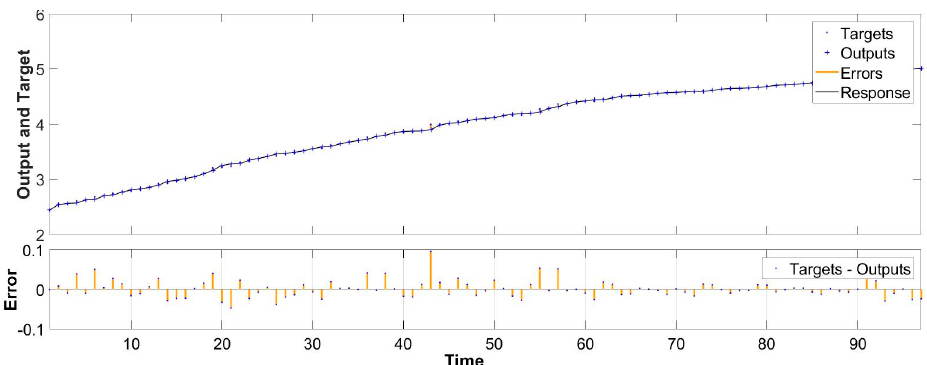
Figure 11. Comparison chart of prediction results.